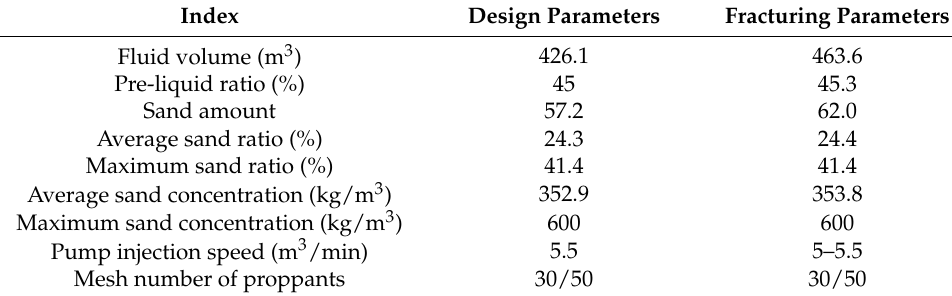
Table 3. Actual fracturing parameters of typical well V5S.